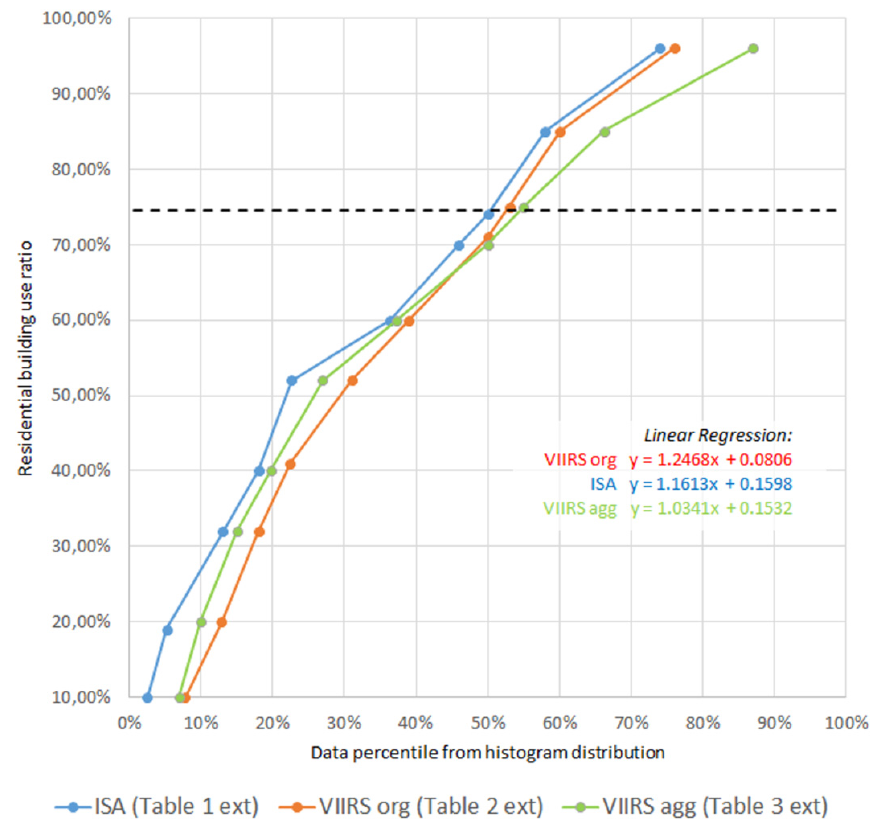
Figure 13. Plot of residential building use ratio vs. data percentile from histogram distribution for ISA (extended data sample of Table 1), original-resolution VIIRS (extended data sample of Table 2), and aggregated VIIRS (extended data sample of Table 3). The dashed line shows the residential building use ratio for Cuenca City (75%) as derived from cadastral data. Regression equations are colored according to the respective graphs.